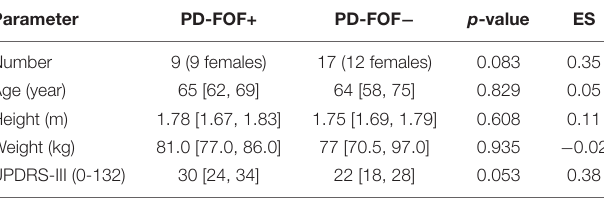
TABLE 1 | Comparison of PD-FOF+ and PD-FOF −